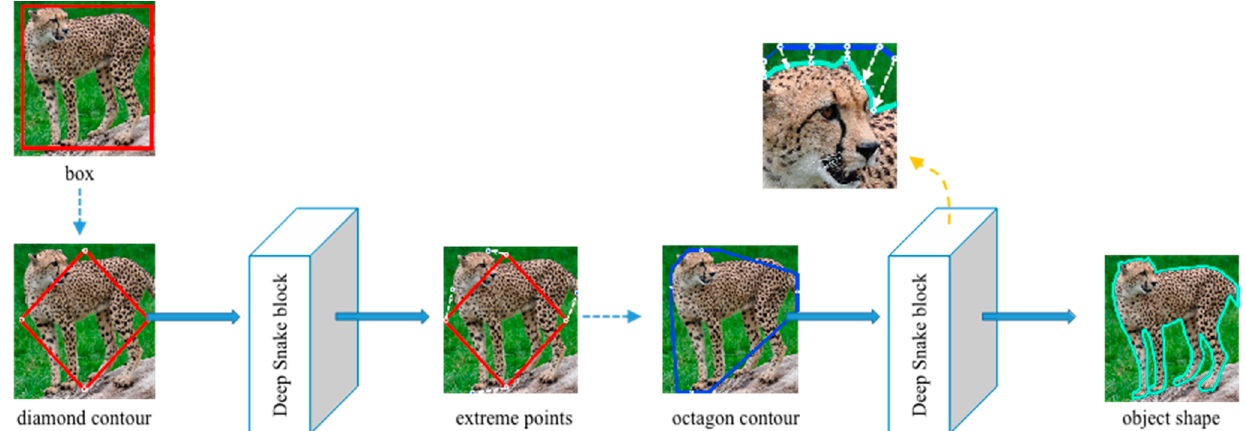
Figure 5. Detailed structure of contour approximation sub-module. We first import the diamond contour formed from the rectangular box into the deep snake block, which outputs the offsets to extreme points. Then, we adjust these extreme points to adapt the contour approximation and put them into the deep snake block again. After multiple iterations, the box finally surrounds the object shape tightly.